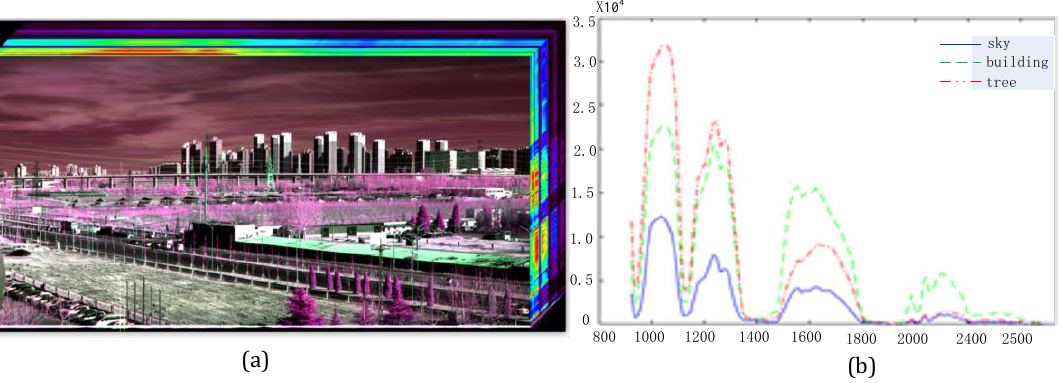
Figure 11. Imaging of external vision: ( a ) data cube of color images, ( b ) spectral reflective DNs of three different objects.